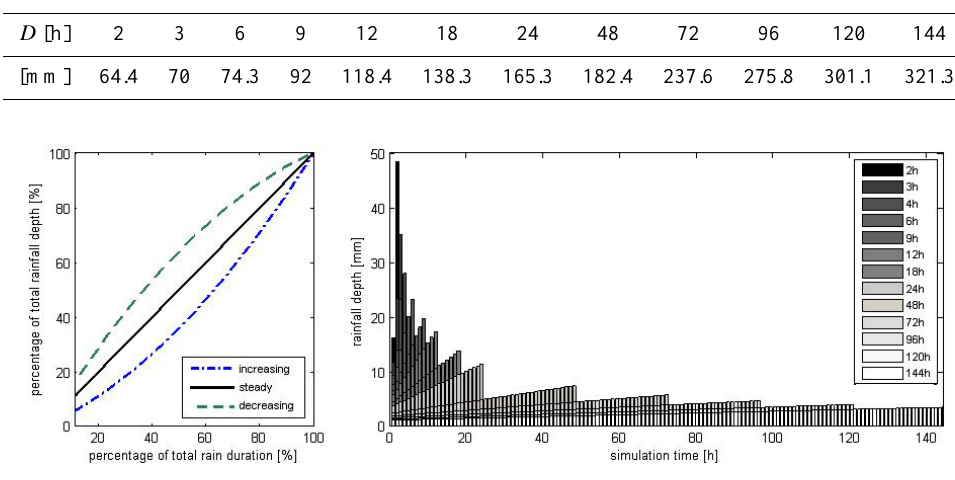
Fig. 5. Design storms with a recurrence interval of T = 5000years for the Gepatschalm catchment. Left side: Different temporal rainfall distributions for a 9hour design storm. Right side: hourly rainfall depths with increasing temporal distribution in the course of the different design storm durations ( D